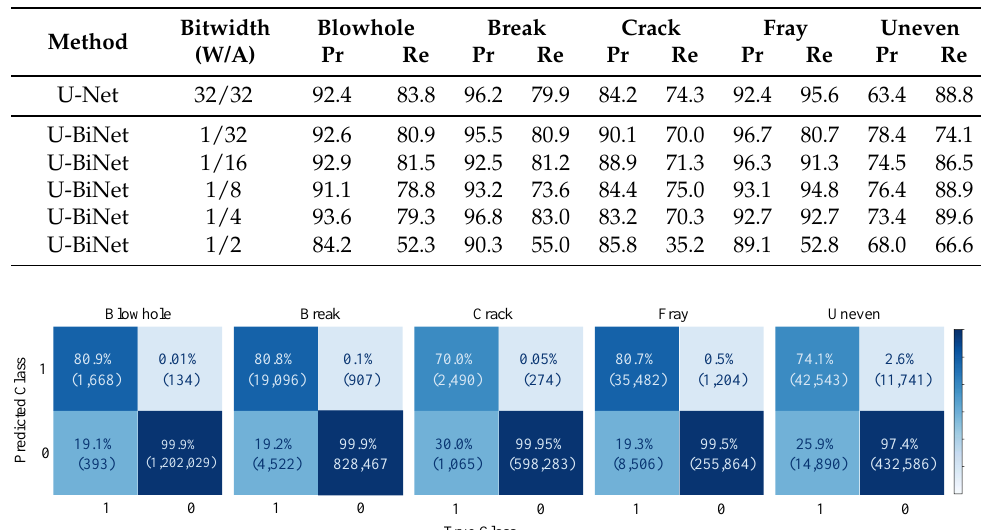
Table 3. Fined-grained defect detection performance on Magnetic Tile (in percentage). ‘Pr’ represents precision and ‘Re’ denotes recall.